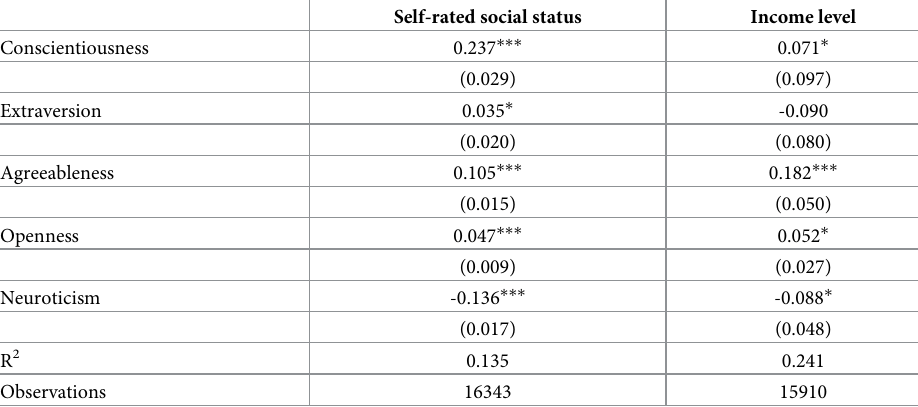
Table 6. Robustness checks: Alternative measures for occupational